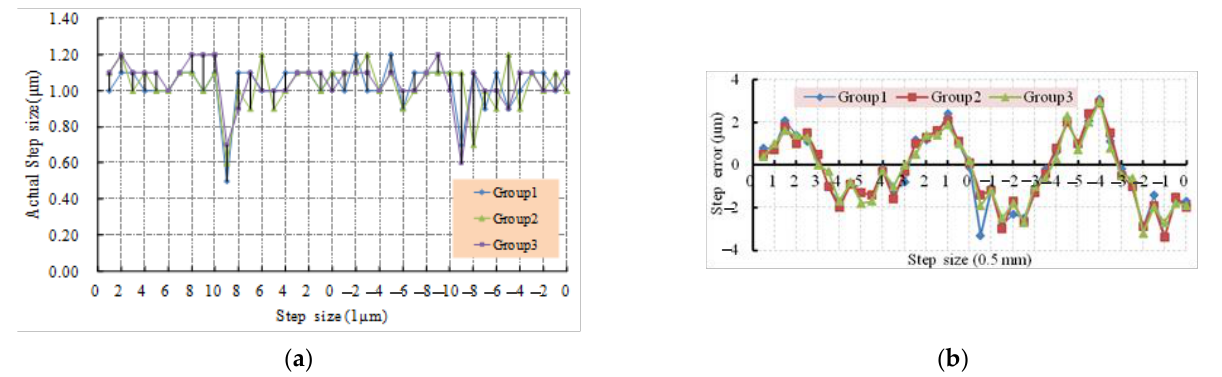
Figure 23. Test results for mobile platform translation along Z -axis: ( a ) Step size: 1 μm; ( b ) Step size: 0.5 mm.